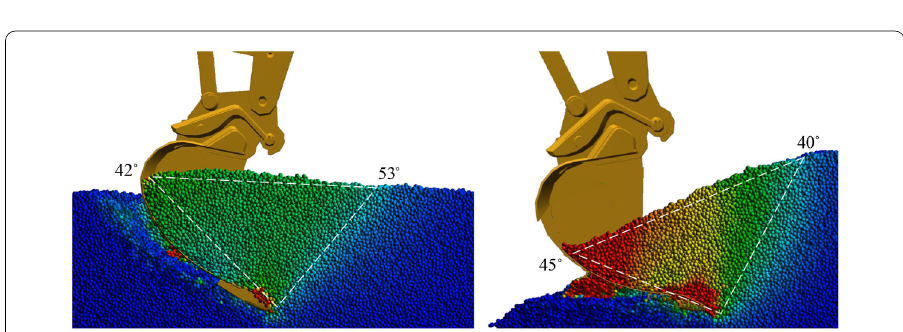
Fig. 19 The resulting surfaces from excavation in three cohesive soils using the multiscale model (top row) and the microscale reference model (middle row). The difference is shown at the bottom row